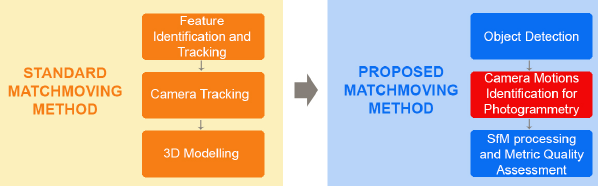
Figure 1. Workflow of the standard match-moving method compared with the method proposed in this